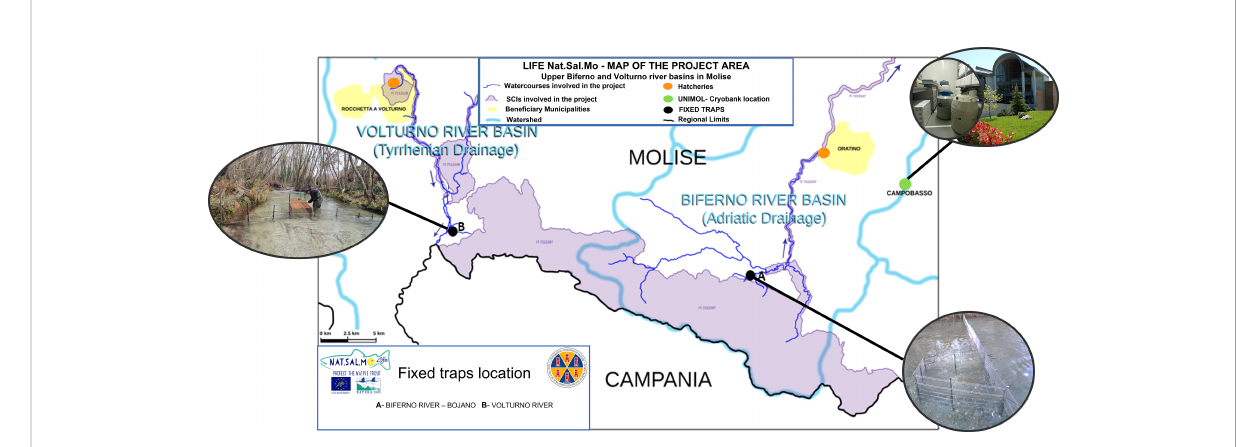
FIGURE 1 Location of the frozen gene bank (University of Molise), hatcheries (Rocchetta a Volturno and Oratino) and fi xed traps (Biferno and Volturno